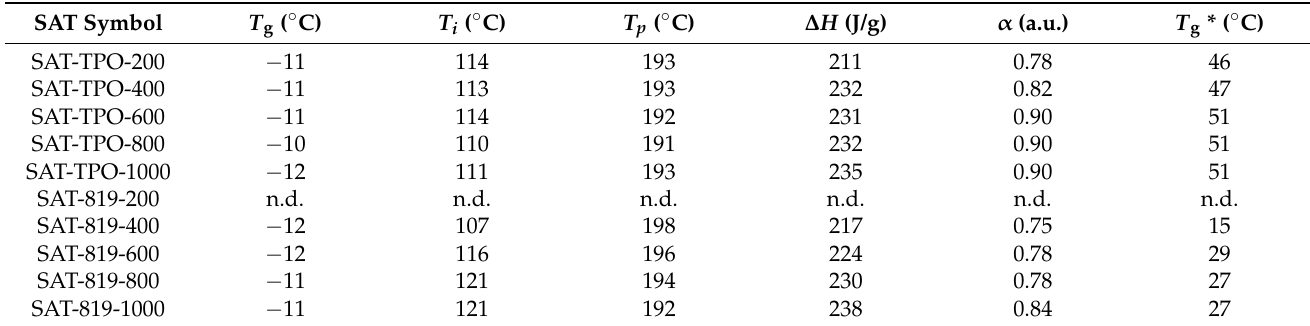
Table 3. Thermal features of the UV-crosslinked structural self-adhesive tapes (SATs), the results from the differential scanning calorimetry (DSC) tests, and the crosslinking degree of the thermally cured SATs. SAT Symbol T g ( ◦